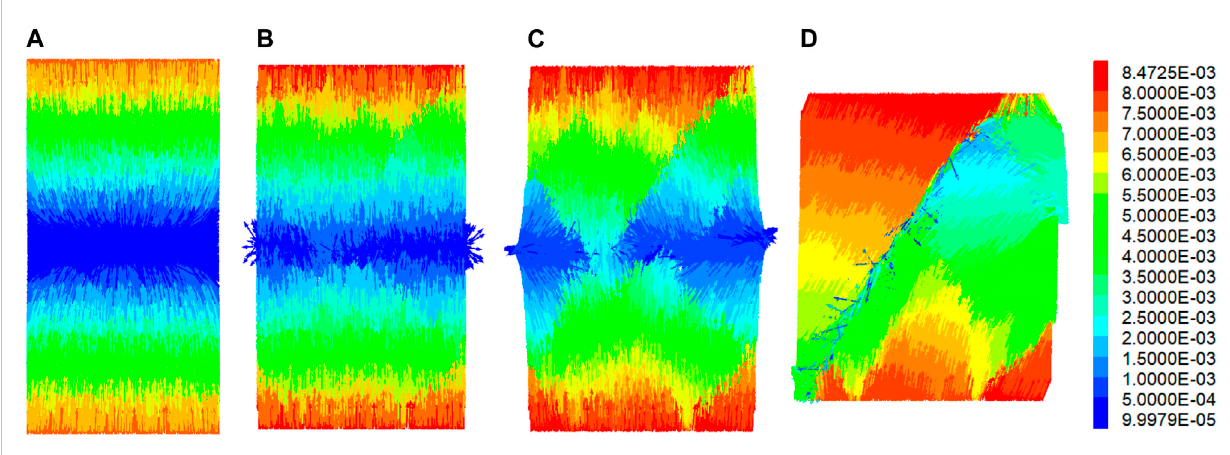
FIGURE 16 Evaluation law of the shear displacement fi eld. (A) ε 1 =1%. (B) ε 1 =5%. (C) ε 1 =10%. (D) ε 1 =15%.